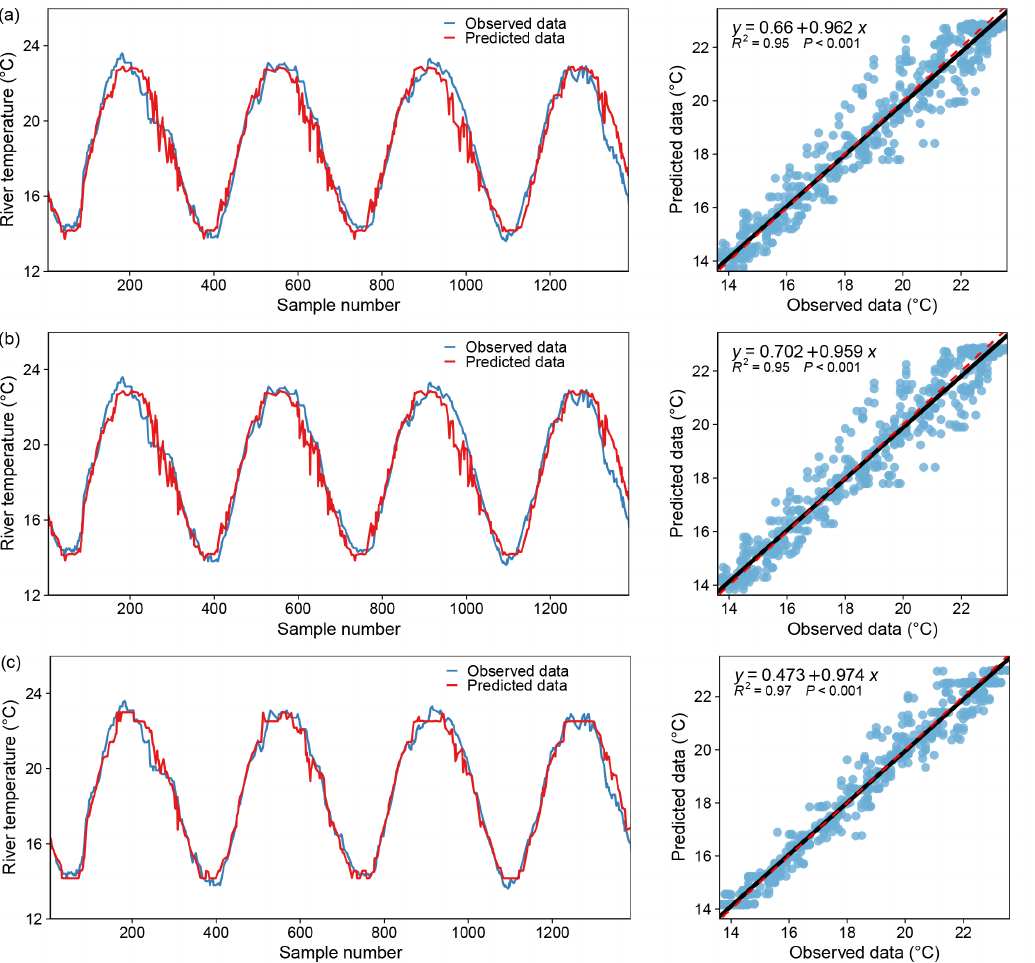
Figure 10. Model fitting results—AdaptiveBoosting Regressor, blue dot: X coordinate (observed data), Y coordinate (predicted data) ; black line: y = x ; red dotted line: the regression curve of the blue dots. ( a ) only one input variable (DOY), ( b ) with two input variables (DOY and Flow), ( c ) with all